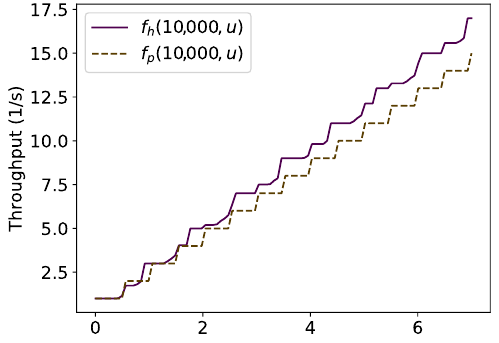
Figure 16. Comparison of f p ( T , u ) and f h ( T , u ) for u ∈ [0,7], T = 10,000 s, v = 1 m/s and d = 1